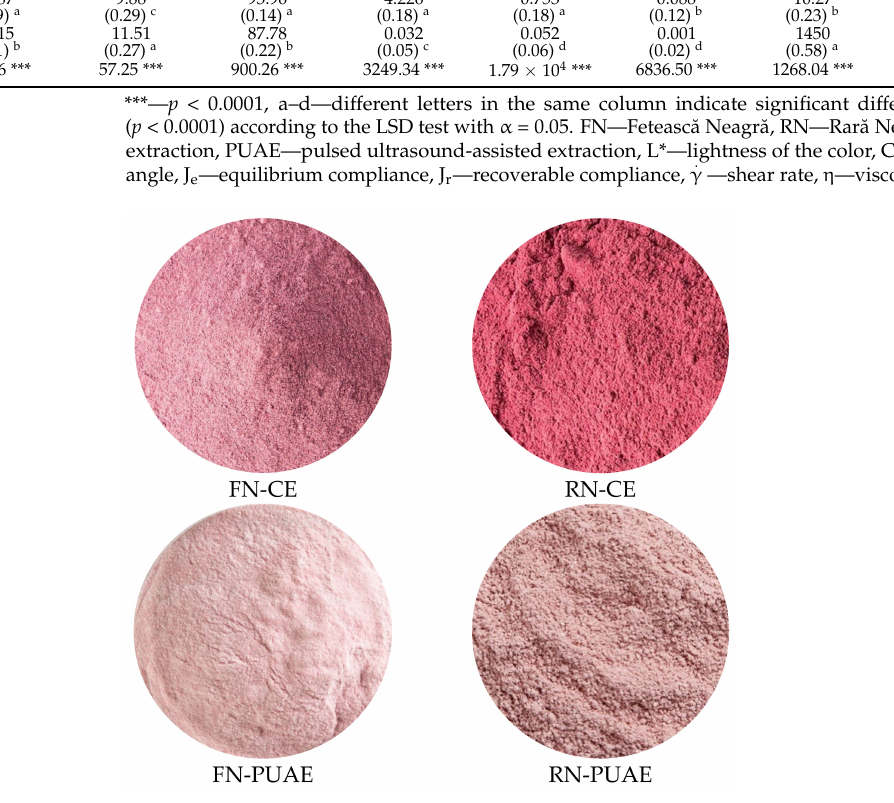
Figure 5. Images of pectin samples extracted from Feteasc ă Neagr ă (FN) and Rar ă Neagr ă (RN) grape pomace by conventional extraction (CE) and pulsed ultrasound-assisted extraction